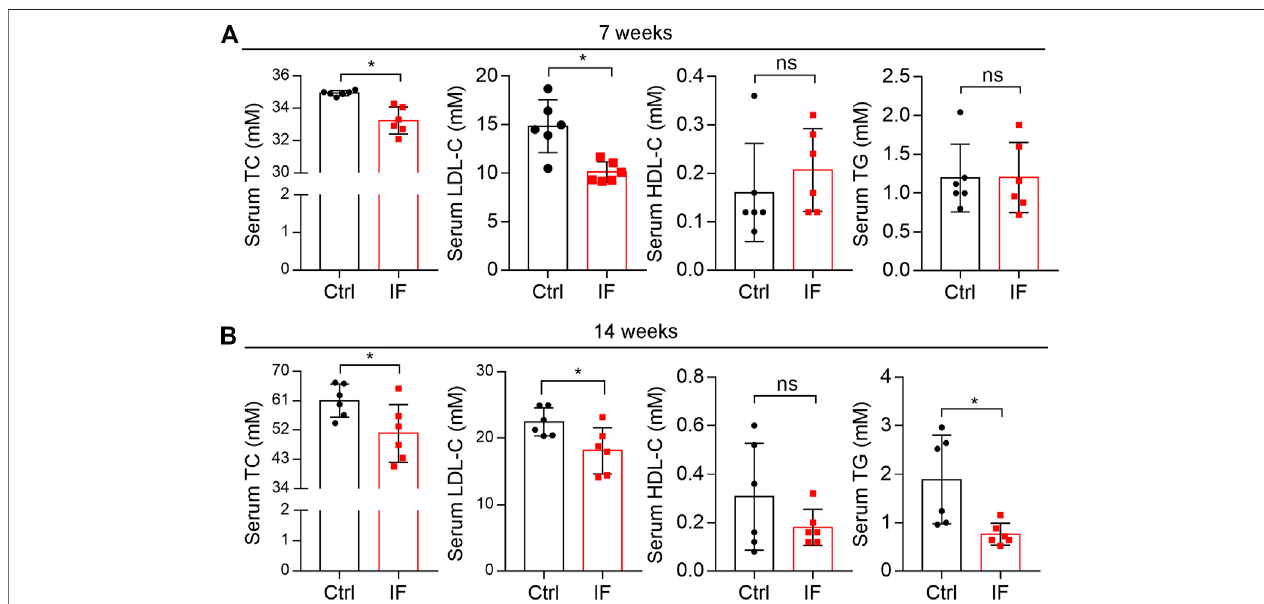
FIGURE4| Intermittent fasting reduceshypercholesterolemia. Mouse serum samplesisolated form LDLR-/- mice after 7 (A) or 14weeks (B) IF feedingwere used todetectlevelsoftotalcholesterol(TC),low-densitylipoproteincholesterol(LDL-C),high-densitylipoproteincholesterol(HDL-C),andtriglyceride(TG)usinganautomatic biochemical analyzer. * p < 0.05, ns: not signi fi cant ( n (cid:1) 6). Ctrl: control; IF: intermittent fasting.